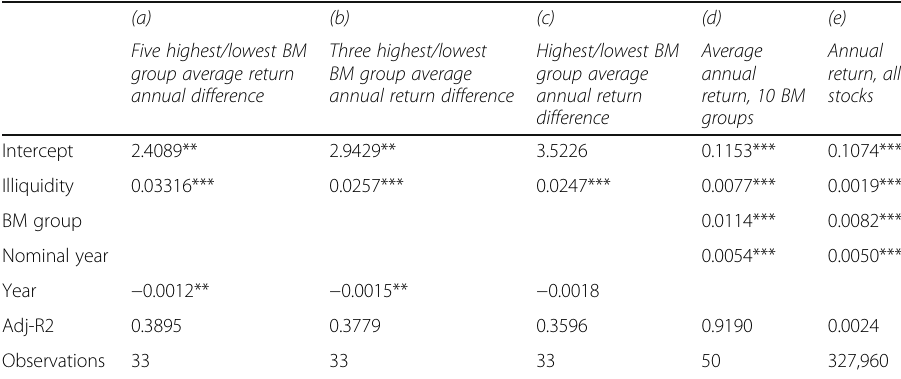
Table 5 Regression analysis: OLS regressions are performed for five samples: (a) Sample of differences across the five highest and five lowest BM groups for the variables average post-portfolio formation returns and normalized illiquidity; (b) Same as (a), for the three highest and three lowest BM groups; (c) Same as (a), for the highest and lowest BM groups; (d) Sample of average annual returns and illiquidity across BM groups and post-portfolio formation years; (e) Sample of annual returns for each stock for each post-portfolio formation